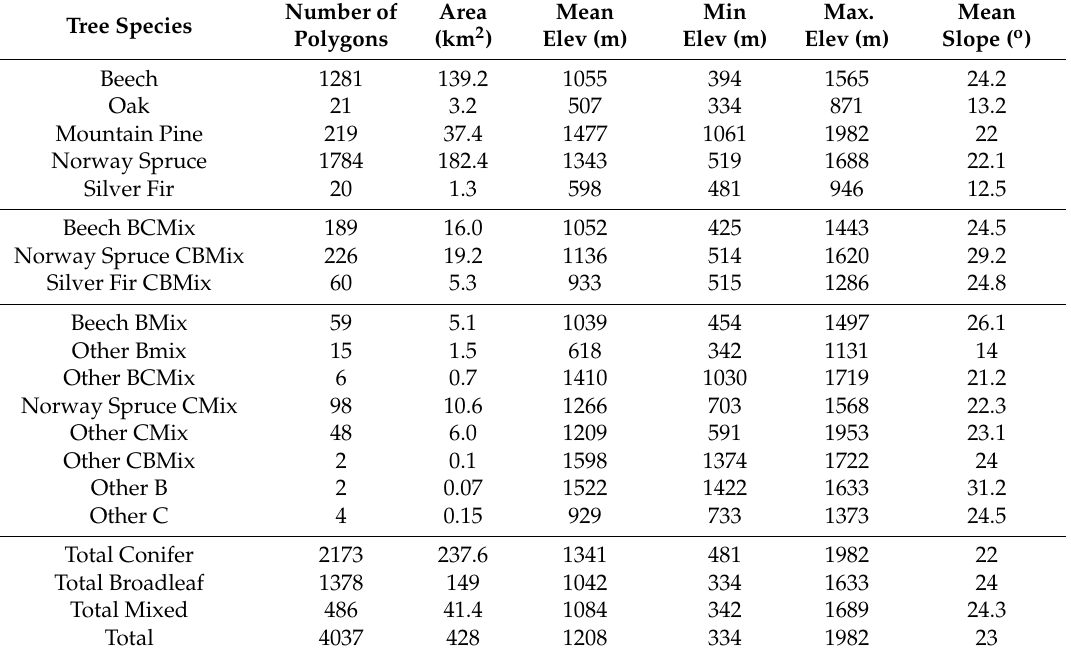
Table 1. Number and area of polygons used in this study (not including polygons damaged by man) for different tree species in OGF polygons. We denoted mixed tree species polygons as “Dominant Tree Species Mix,” while C and B stand for conifer and broadleaved respectively. Thus, Norway Spruce CBMix is Norway spruce dominant mixed with at least 20% broadleaved species, while Beech BMix is beech dominated mixed with at least 20% other broadleaved species. Tree